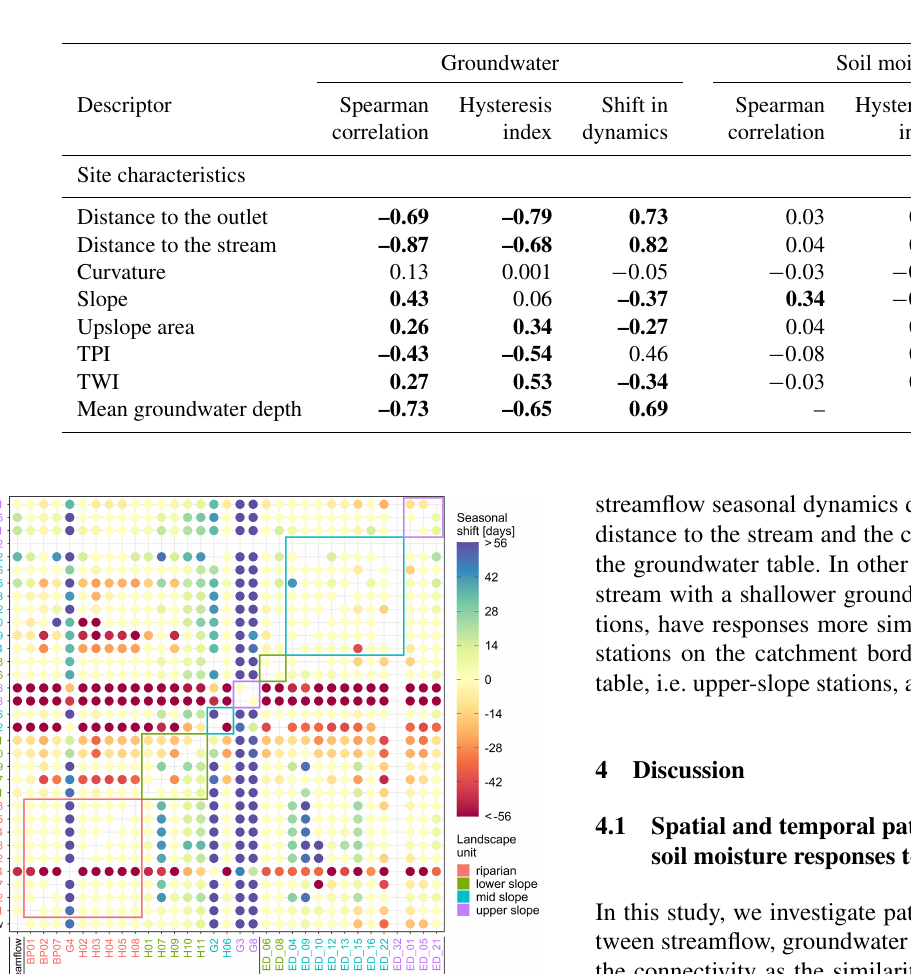
Table 4. Pearson correlation coefficient between site characteristics and the Spearman correlation, hysteresis index and time shift of ground- water and soil moisture seasonal dynamics in relation to streamflow. TPI and TWI are topographic position index and topographic wetness index, respectively. Significance of correlations was tested with t -distribution approximation and correlations with p < 0 . 05 are shown in bold.